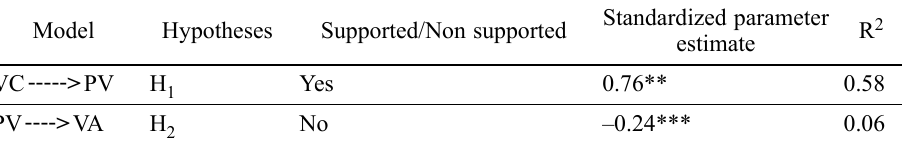
Table 3. Summary of